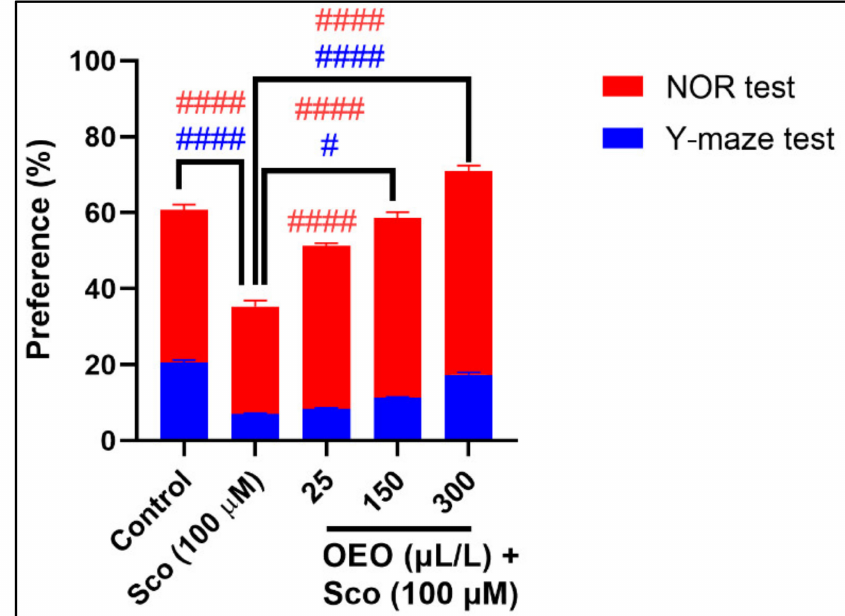
Figure 6. Comparative analyses of zebrafish preference for novelty behavior for the control, Sco (100 µ M) and OEO (25, 150, 300 µ L/L) group treatment, based on spatial memory parameters for the novel object recognition test (NOR) vs. the Y-maze test. Values are means ± S.E.M. ( n = 10). For Tukey’s post hoc analyses: # p < 0.01 and #### p <